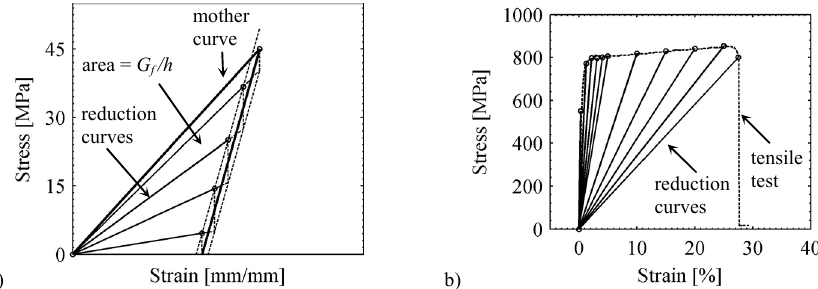
Figure 3: Exemplary reduction curves for a) glass, with 5 reduction steps, and b) steel with 10 reduction